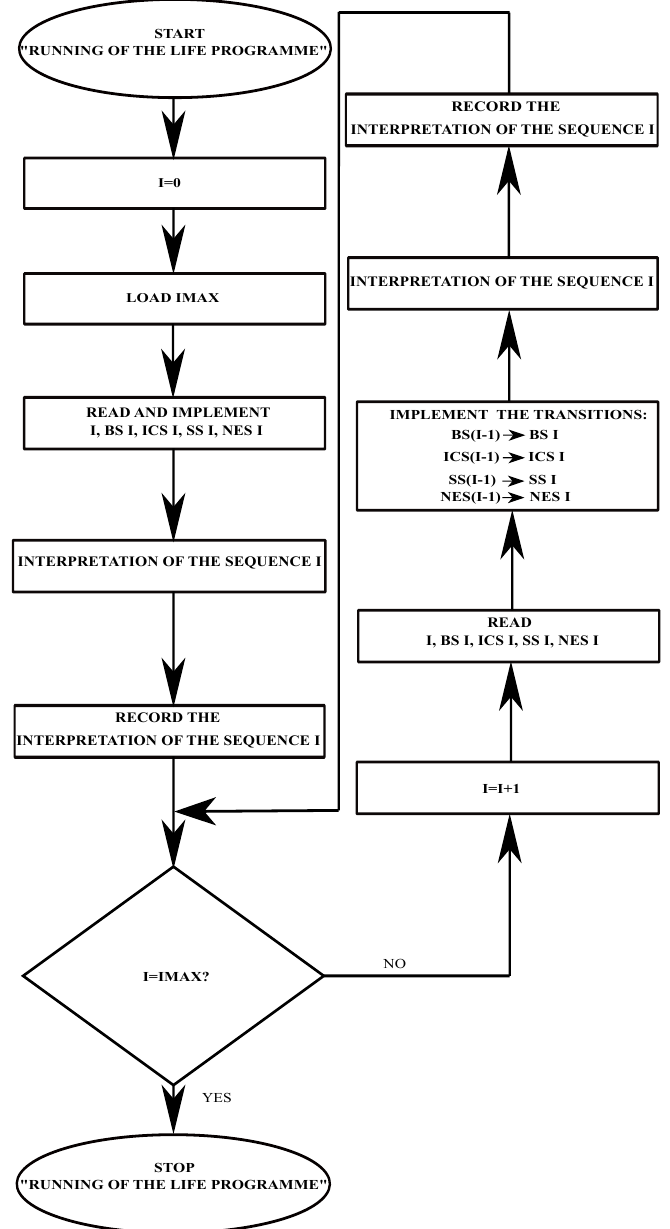
Figure 4. Running of the life